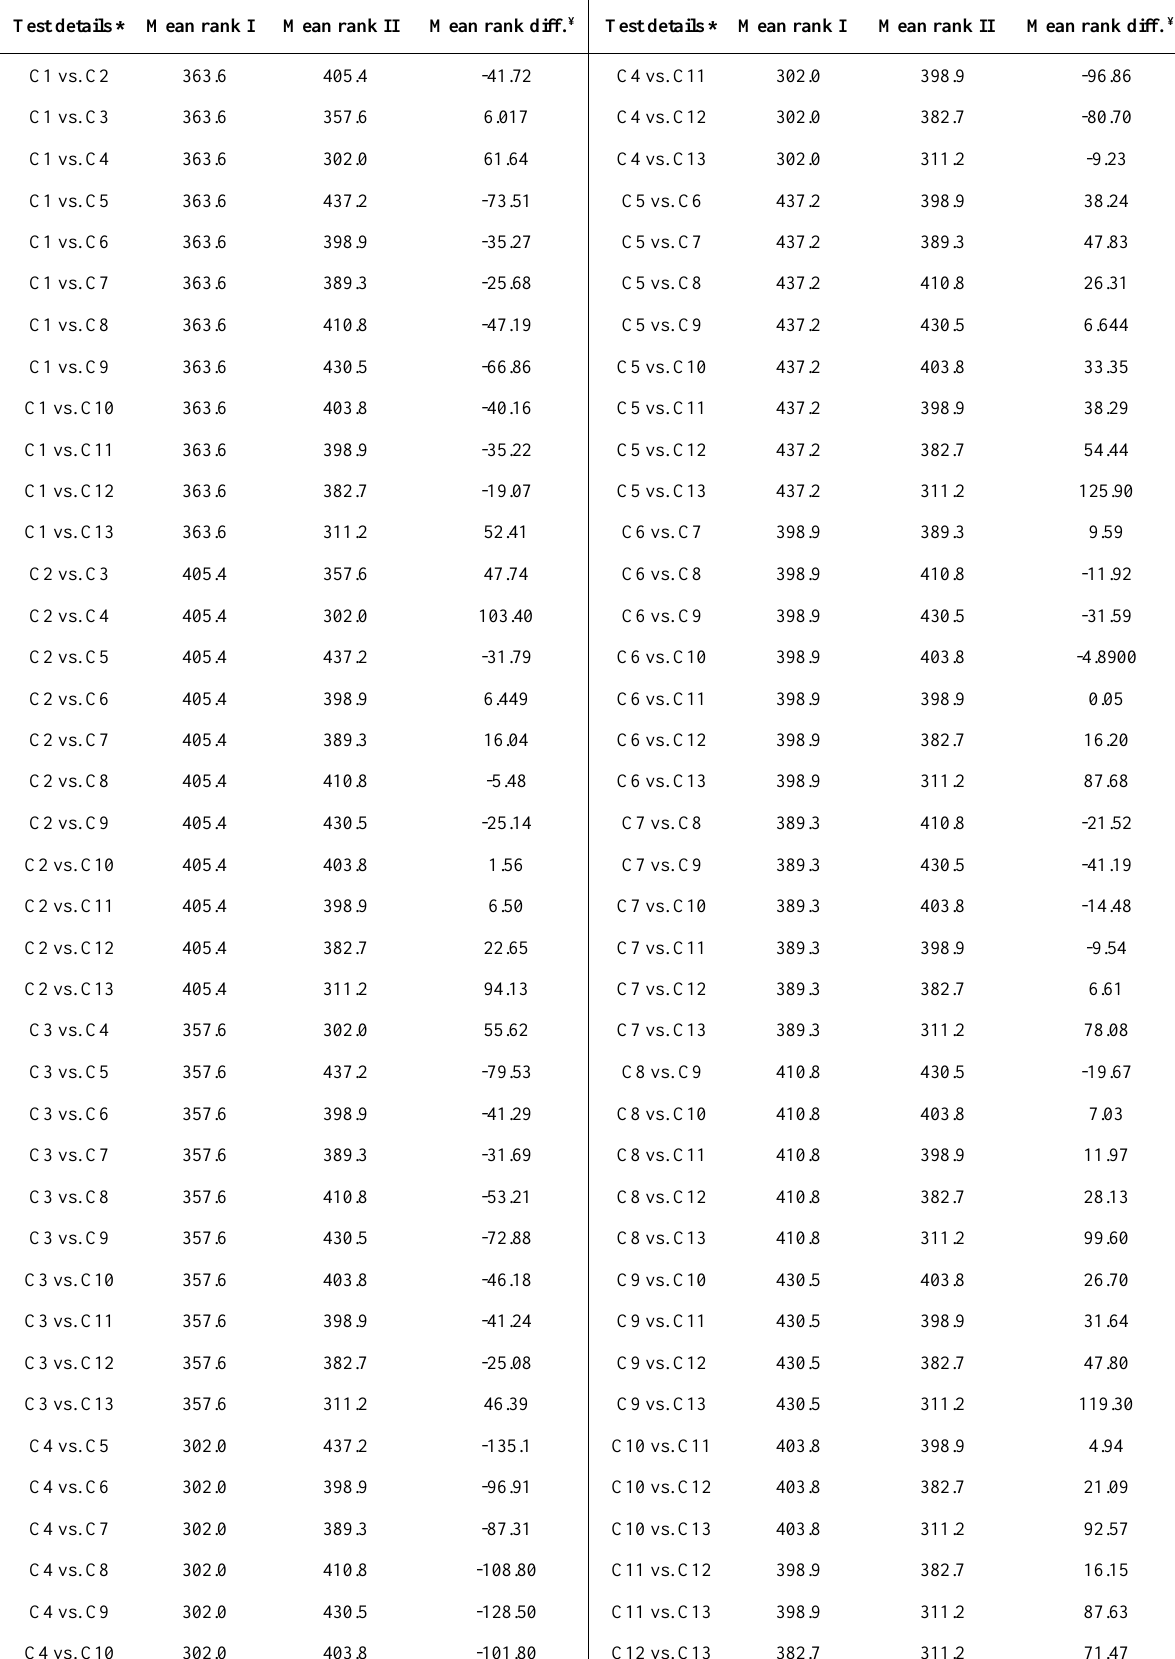
Table 1. Kruskal-Wallis test for 13 treatment (columns) of 767 total values with 78 multiple pairwise comparisons per